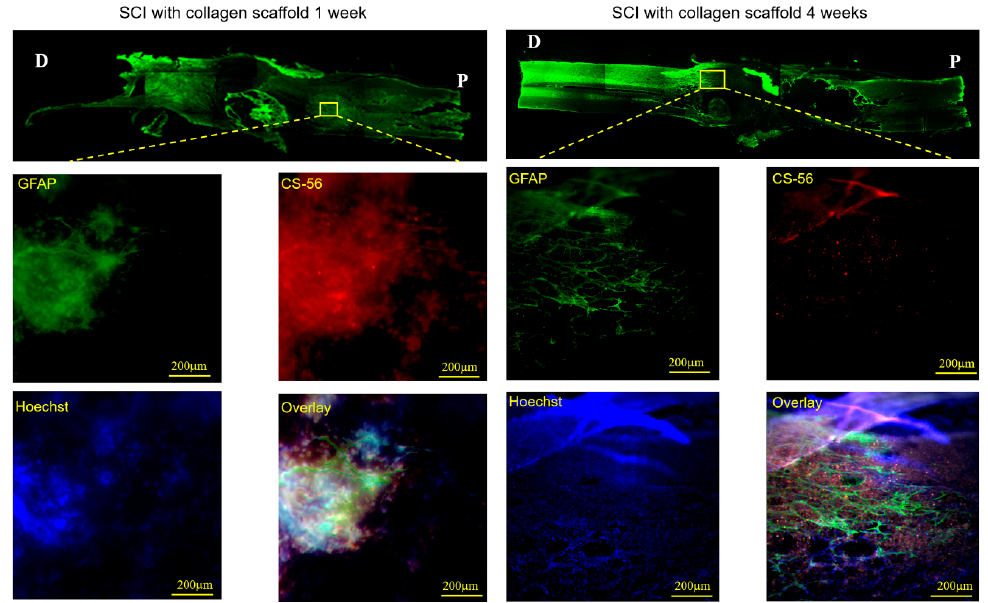
Figure 8. Immunofluorescence staining with Hoechst 33342, glial fibrillary acidic protein (GFAP), and anti-chondroitin sulfate antibody (CS-56) in the injured site of the spinal cord treated with collagen sca ff old 1 week and 4 weeks